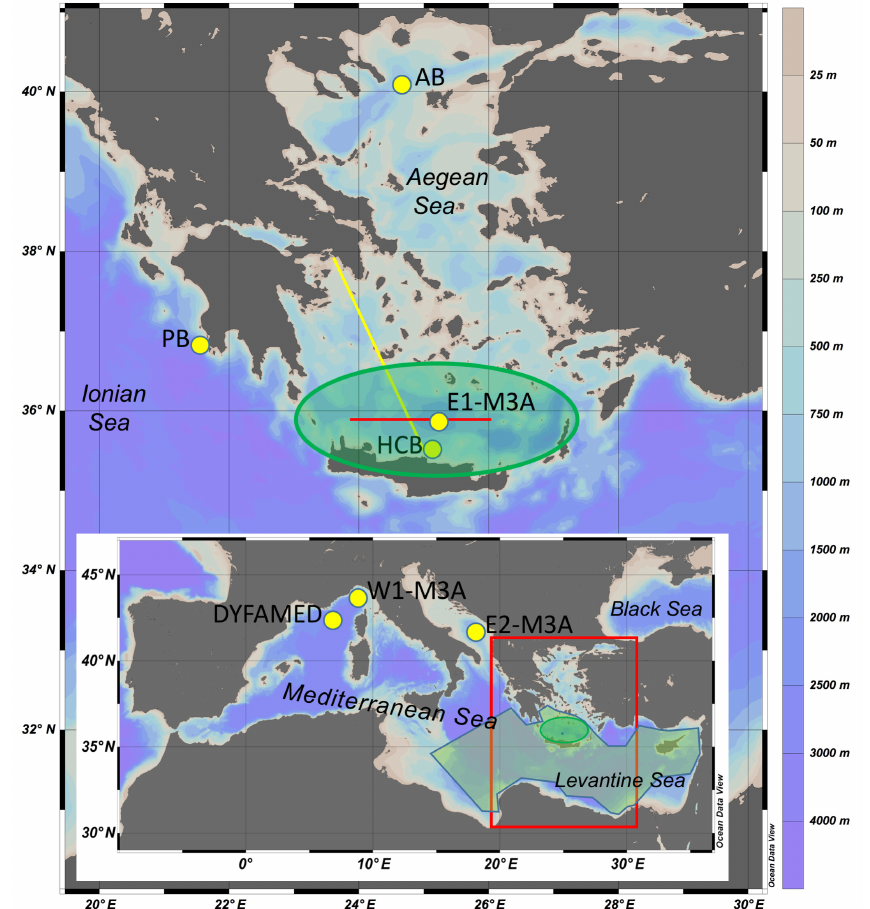
Figure 1. Map of showing the location of the Cretan Sea (green ellipse) and all POSEIDON system physical–biogeochemical fixed platforms (yellow dots; see Sect. 4.1), glider endurance line (red line; see Sect. 4.5) and Ferrybox (yellow line; see Sect. 4.3). Inset map shows the location within the Mediterranean Sea (red square), location of other biogeochemical (BGC) fixed platforms (from http://www.oceansites.org, last access: 26 September 2018) and E1-M3A spatial footprint (green area) for Chl- a using satellite observations (redrawn after Henson et al., 2016). The E1-M3A location includes, in addition to the BGC fixed platform, an acoustic Doppler current profiler (ADCP) and sediment